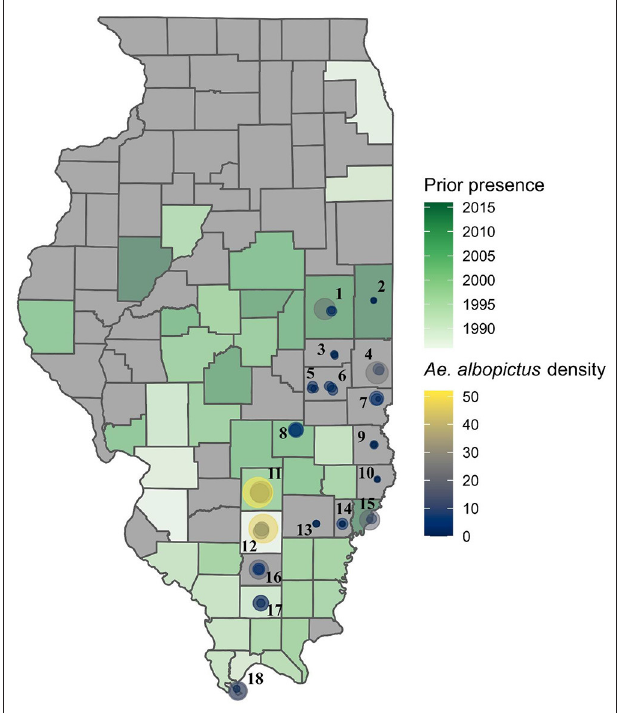
FIGURE 2 | Sites within southern and eastern Illinois where mosquito surveys were performed in 2016 and 2017, first year of recorded occurrence of Aedes albopictus by county, and the mean density per trap per night for the sampling sites. Numbered sites: 1-Champaign; 2-Danville; 3-Tuscola; 4-Paris;